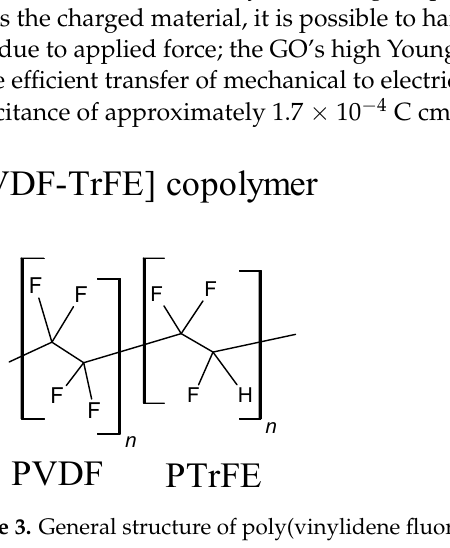
Figure 3. General structure of poly(vinylidene fluoride-co-trifluoroethylene).